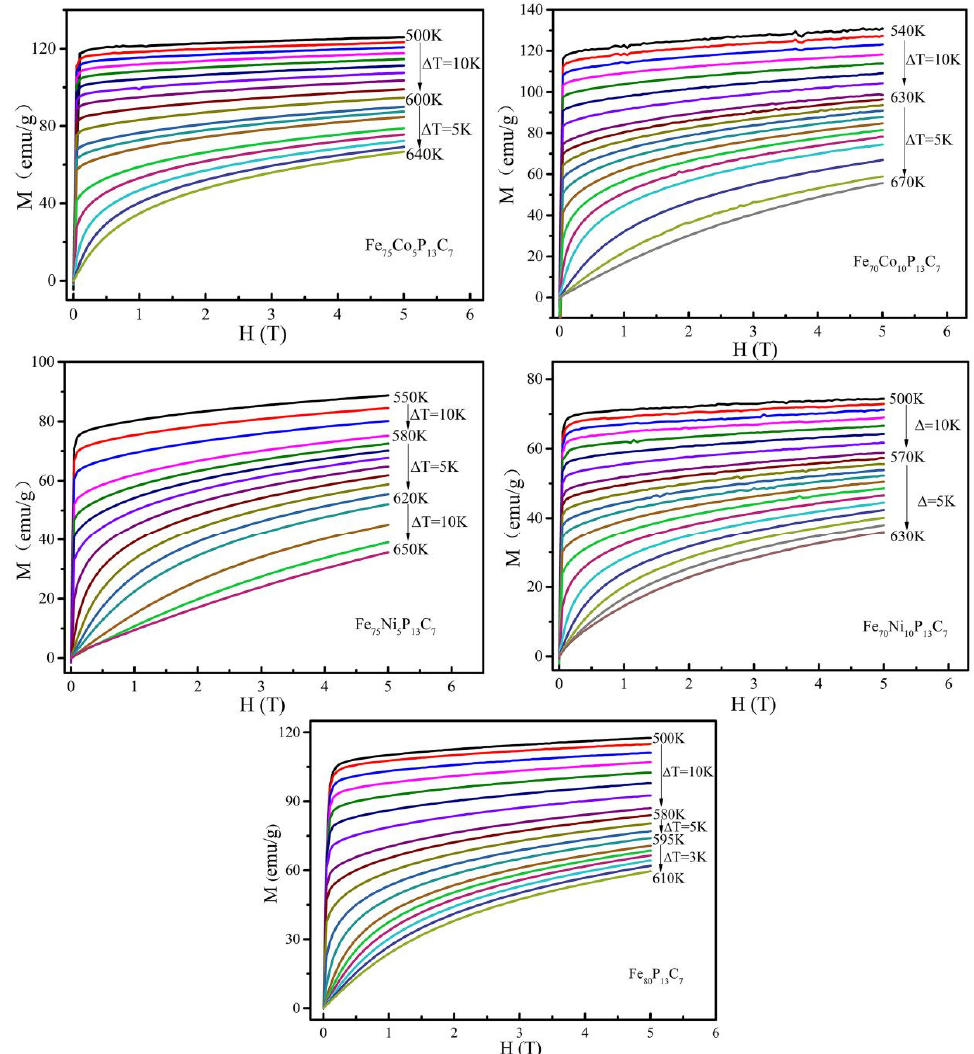
Figure 5. The isothermal magnetization curves of Fe 80-x M x P 13 C 7 (M = Co, Ni; x = 0, 5 and 10 at.%) glassy alloy rods at the magnetic applied fields up to 5 T.